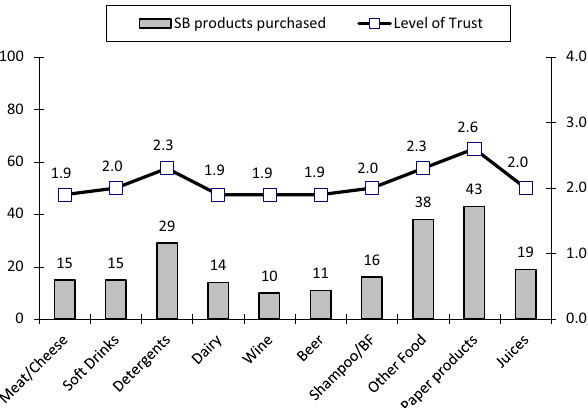
Figure 1. Penetration of store brand product categories and level of